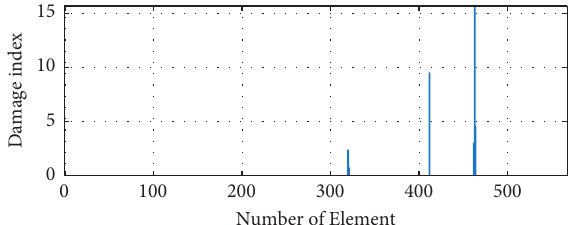
Figure 34: Results of multidamage case D5 using MCA-DI (building with the unsymmetrical distribution of columns).